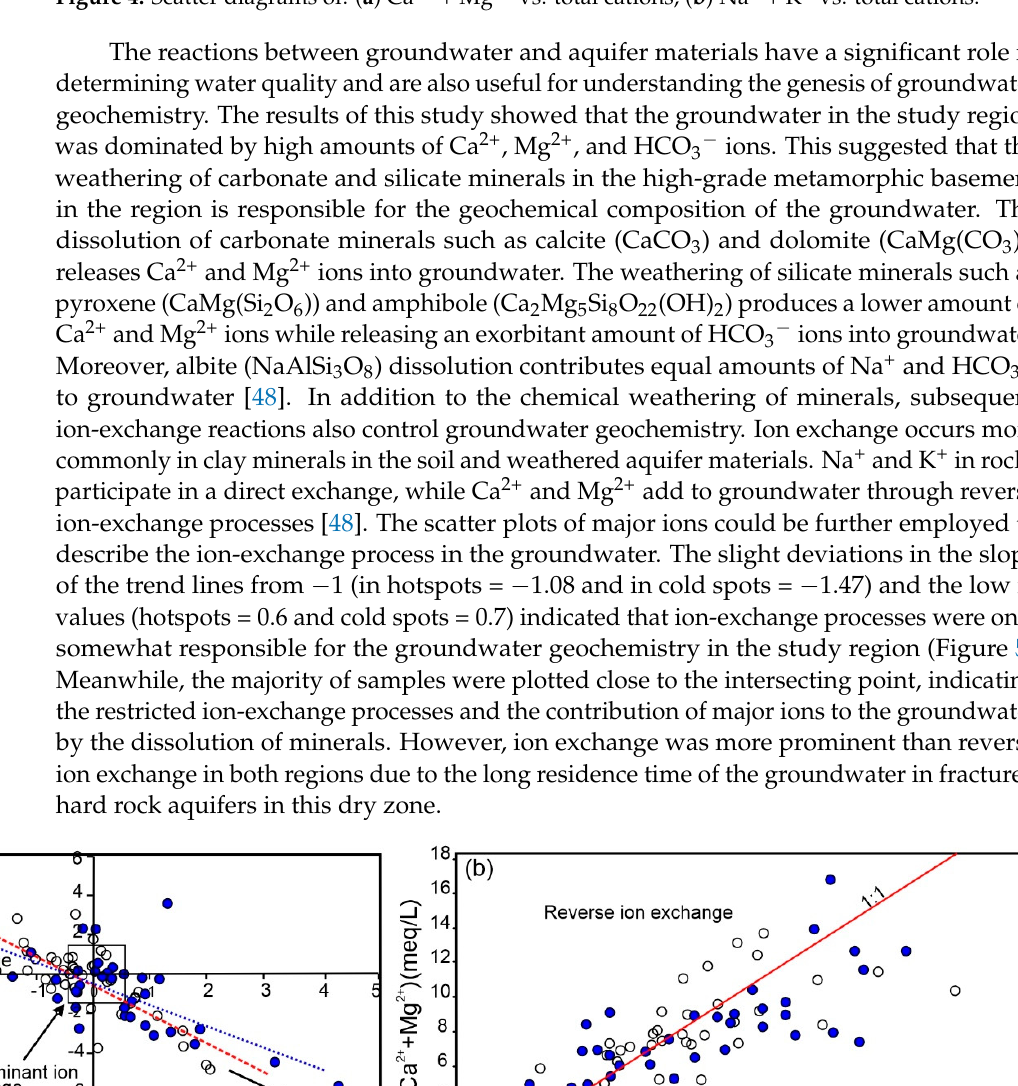
Figure 4. Scatter diagrams of: ( a ) Ca 2+ + Mg 2+ vs. total cations; ( b ) Na + + K + vs. total cations.